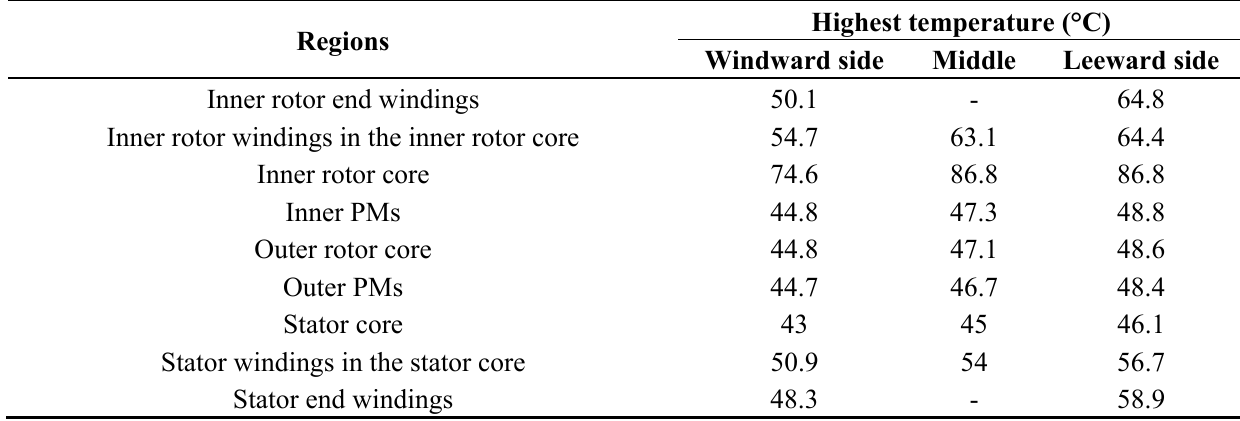
Table 7. Highest temperatures of different parts in the CS-PMSM.